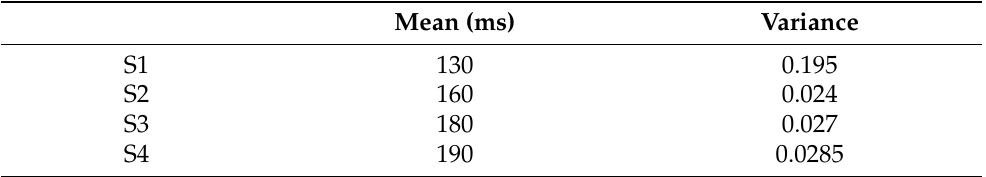
Table A1. Mean and variance communication delay using the Gaussian distributed random